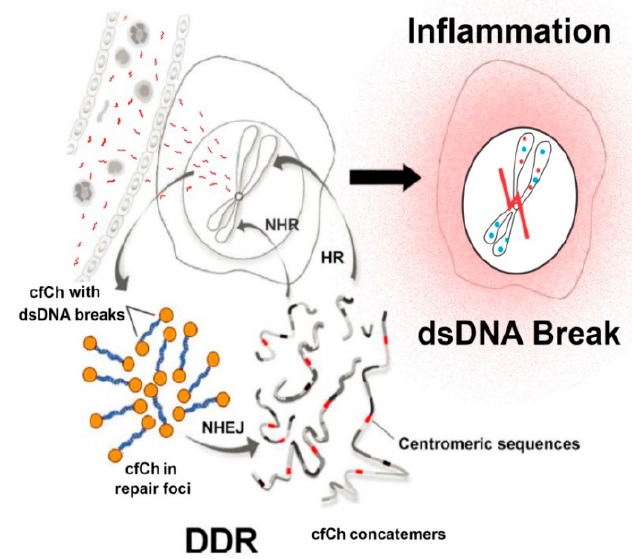
Figure 8. Schematic representation of a proposed model of DNA damage and inflammation following cellular uptake of cfCh. NHEJ = non-homologous end-joining; HR = homologous recombination; NHR = non-homologous recombination. Reproduced with modification from Chaudhary et al. 2018.